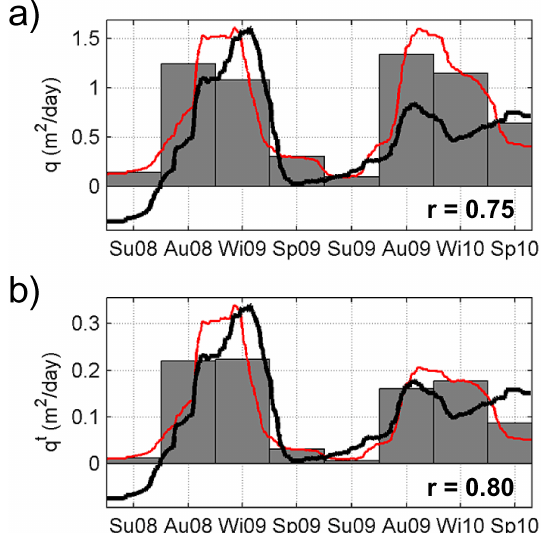
Figure 14. Sediment transport evaluation. Analysis of (a) along- shore component of sediment transport q (without tidal correction), and (b) q t (with tidal correction). The grey areas show the season- ally averaged transport and the red lines show the time-dependent sediment transport time series (obtained by averaging over the T k intervals). The black lines represent the behaviour of the bar migra- tion rate V m that has been rescaled with the above variables. The correlation coefficient of both lines is shown in the bottom right corner. The bottom axes indicate the seasons, from summer 2008 to spring